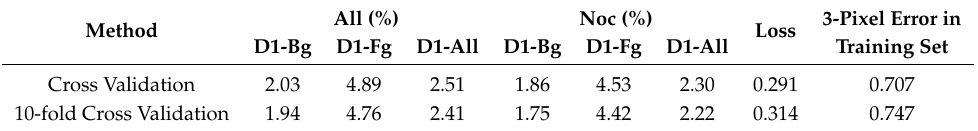
Table A1. The re-implementation of PSMNet with cross validation and 10-fold cross validation. Both follow the same implementation details in Section 5.1.2. We calculate the average 3-pixel error of all image pairs in the whole training set with the model we submitted for